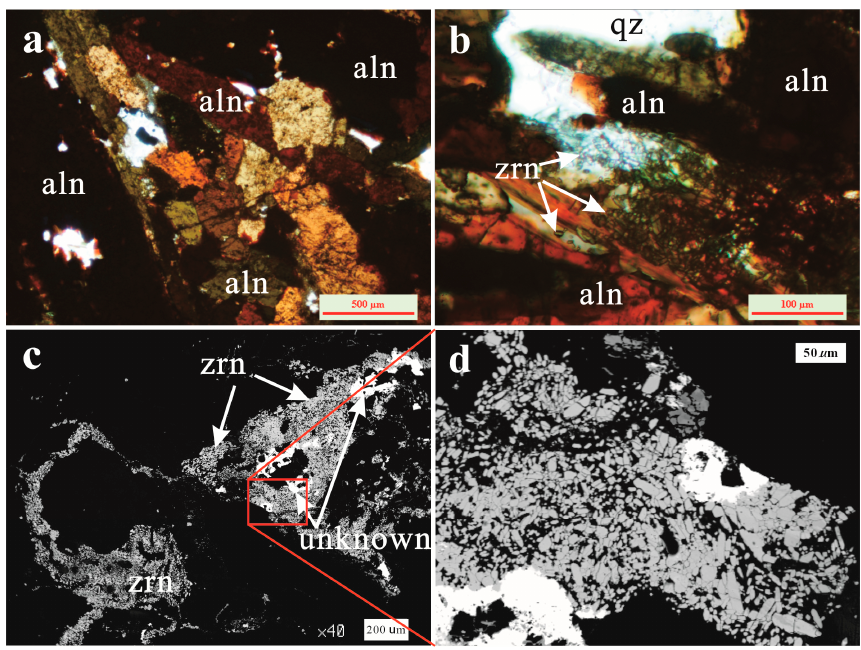
Figure 3. Photomicrograph showing the paragenesis of the quartz–allanite vein. ( a ) Coarse-grained allanite. ( b ) Coarse-grained allanite, quartz, and aggregates of microcrystalline zircon. ( c ) Irregular shape of the aggregates of microcrystalline zircon (Back-scattered electron image). ( d ) Enlarged part of figure c. Zircon present varied in grain size (from 5 to 50 µm) and shapes. Abbreviations: aln (allanite), qz (quartz), and zrn